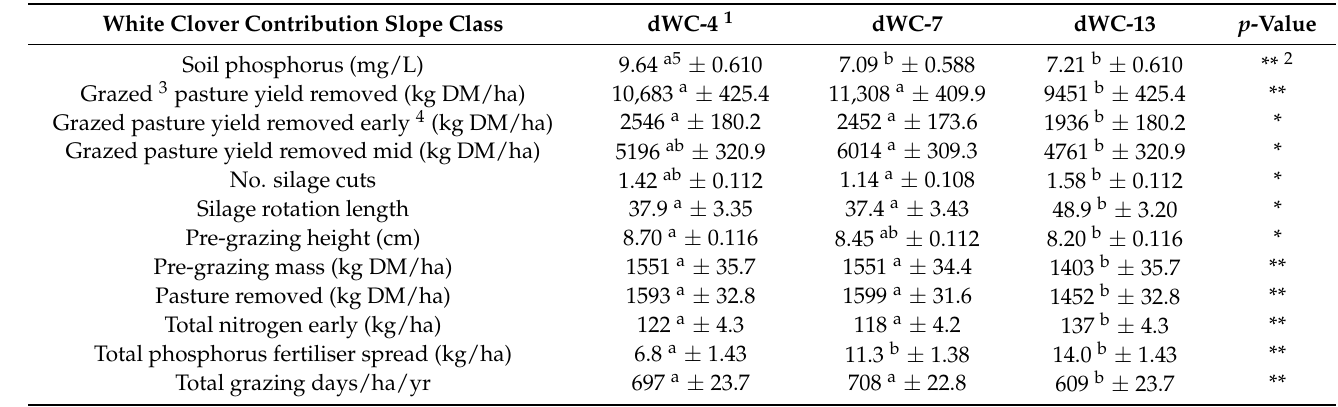
Table 5. Comparison of paddocks in different declining white clover (dWC) classes for pasture growth, soil phosphorus and grazing